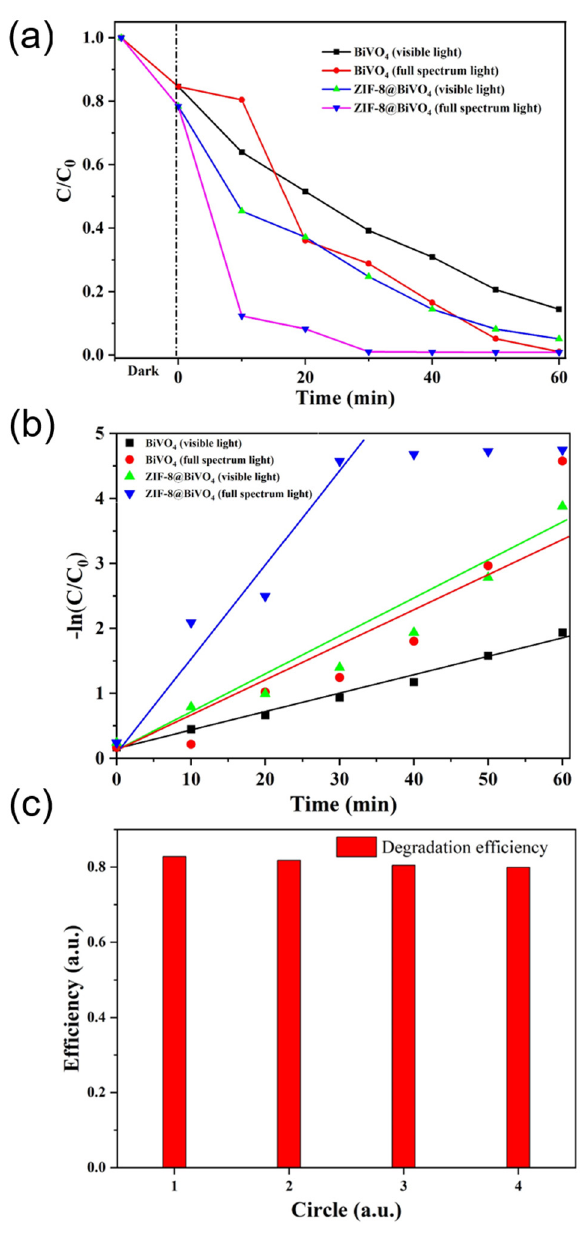
Figure 7. ( a ) The photodegradation efficiency of BiVO 4 and BiVO 4 @ZIF − 8 under full-spectrum and visible light. In the presence of BiVO 4 -ZIF 8, more than 90% of RhB is degraded after 60 min of visible light irradiation, while only 80% of RhB is degraded in the presence of pure BiVO 4 . ( b ) The value of ln (C 0 /C) vs. time for RhB degradation; BiVO 4 @ZIF − 8 shows a higher kinetic constant with the value of 0.133 min − 1 . ( c ) The reproducibility test of photocatalysis.